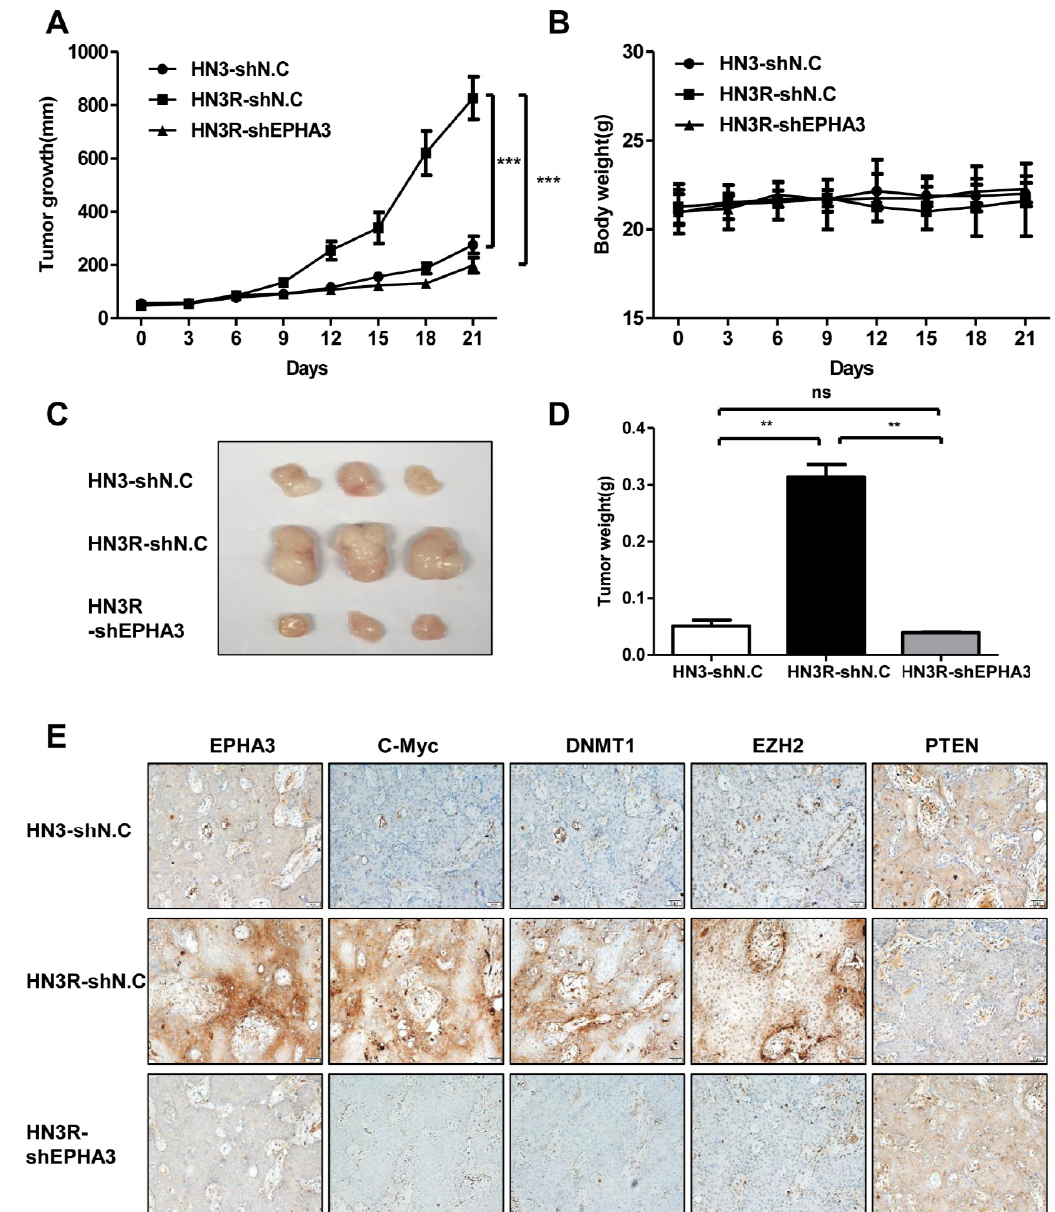
Figure 4. EphA3 inhibition suppress tumor growth through regulation of c-myc, DNMT1/EZH2, and PTEN in an AMC HN3R xenografts model. (A )Tumors were measured regularly, and the relative tumor volume was tracked for each animal (each group: 4 mice). ( B ) Body weight was measured every three days. ( C ) The photographs show representative tumors from each mouse of approximate 3 weeks. ( D ) Tumor weight was examined in each treatment groups at 21 days. ( E ) Immunohistochemical staining was performed in mouse tumor specimens. Representative photographs are shown. **, P < 0.005; ***, P < 0.0001.